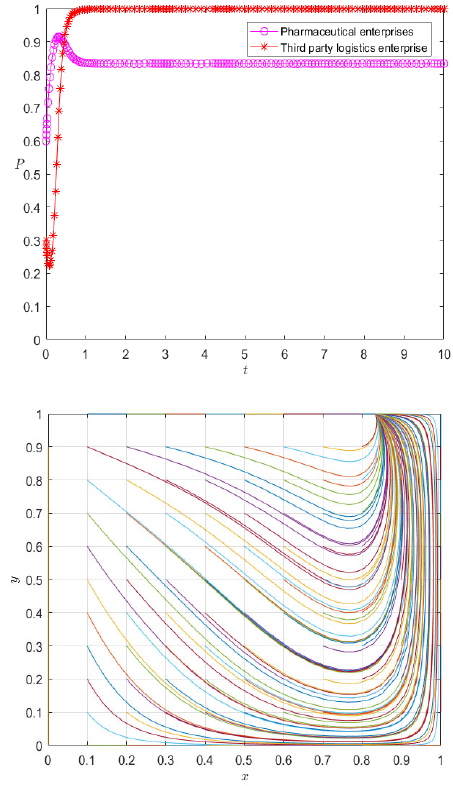
Figure 11. Evolution paths of pharmaceutical enterprises and 3PL enterprises under the dynamic premium and penalty mechanism.